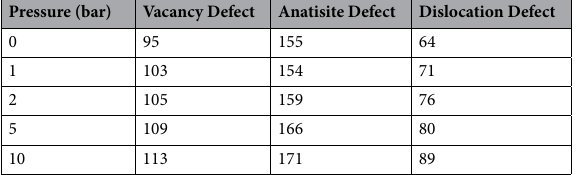
Table 4. Changes in the number of involved atoms in vacancy, antisite, and dislocation defects at different pressures.